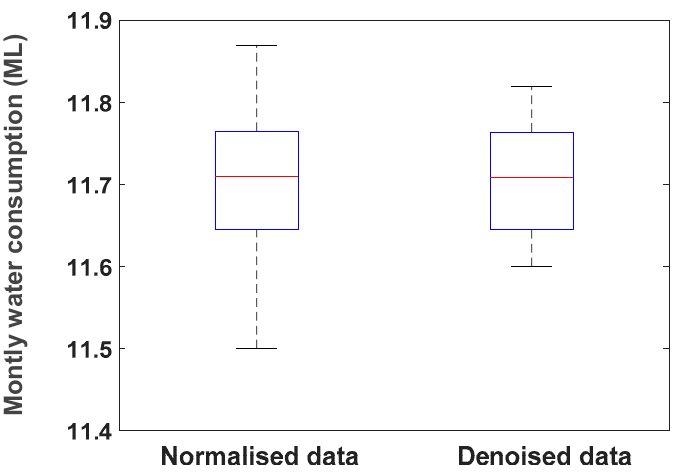
Figure 3. Box plot distribution for normalized and denoised data.